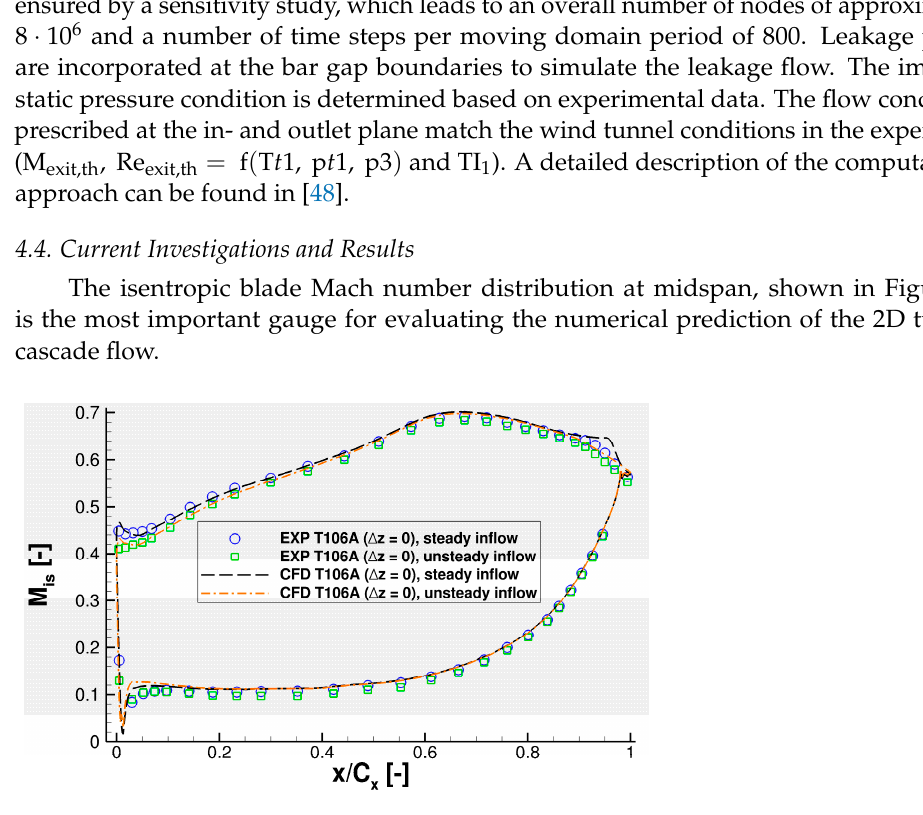
= 0.59, Re = 2 · 10 5 exit,th exit,th